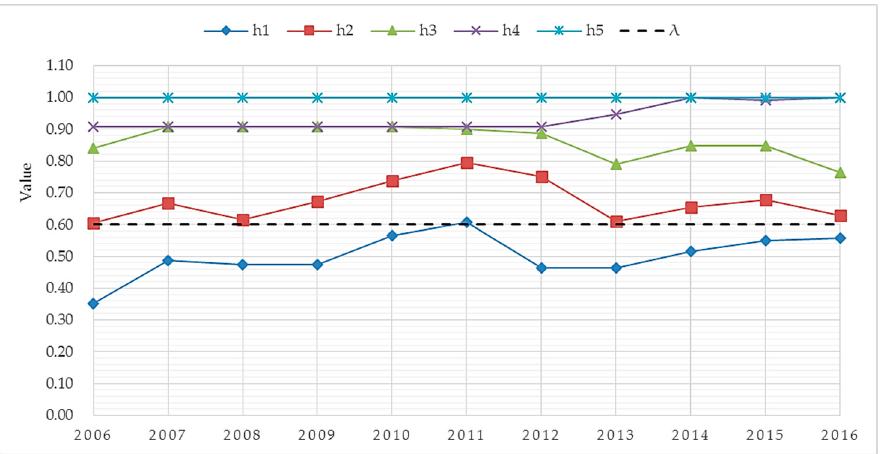
Figure 4. Cumulative connection degree trends for the pressure subsystem from 2006 to 2016.